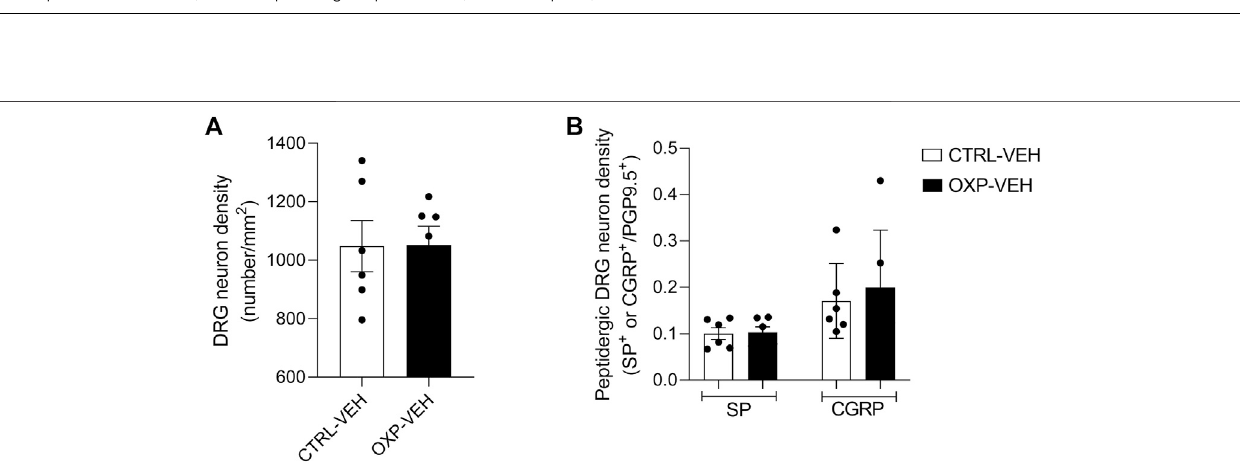
(CTRL-RAM vs. CTRL-VEH, p (cid:1) 0.9318), or D5 (CTRL-RAM vs. CTRL-VEH, p (cid:1) 0.6117) ( Figure 3 ). Ramipril tended to improve tactile sensitivity in OXP-treated mice at D3 (OXP-RAM vs.